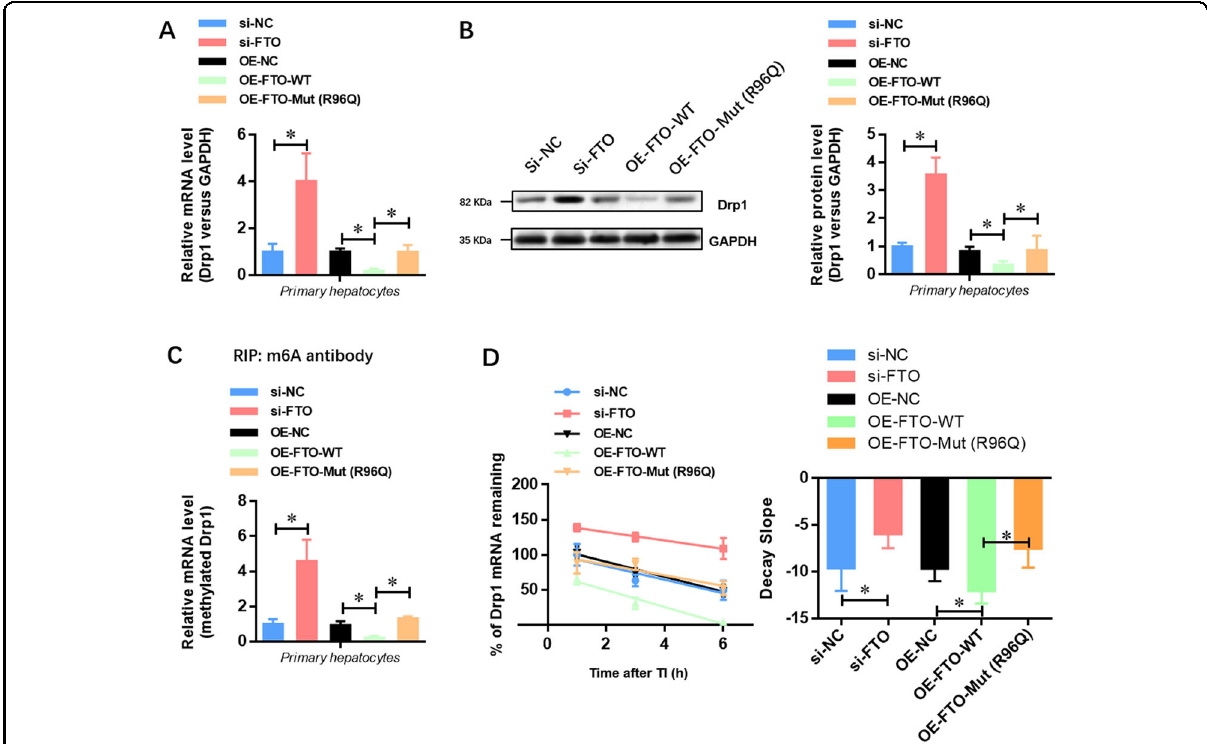
Fig. 6 Drp1 is a downstream target of FTO in the progression of HIRI. A qRT-PCR analysis showed that overexpression of wild-type but not demethylase- mutated FTO decreased the Drp1 mRNA level in isolated hepatocytes. B Western blotting analysis showed that overexpression of wild- type but not demethylase-mutated FTO decreased the Drp1 protein level in isolated hepatocytes. C Me-RIP qRT-PCR analysis showed that overexpression of wild-type but not demethylase-mutated FTO decreased the methylated Drp1 level in isolated hepatocytes. D The curve and statistical analysis of Drp1 mRNA decay slope on the transfection of FTO siRNA, FTO-WT, FTO-Mut (R96Q), or the negative control after transcriptional inhibition (TI) were shown. N = 3; * P < 0.05 versus indicated